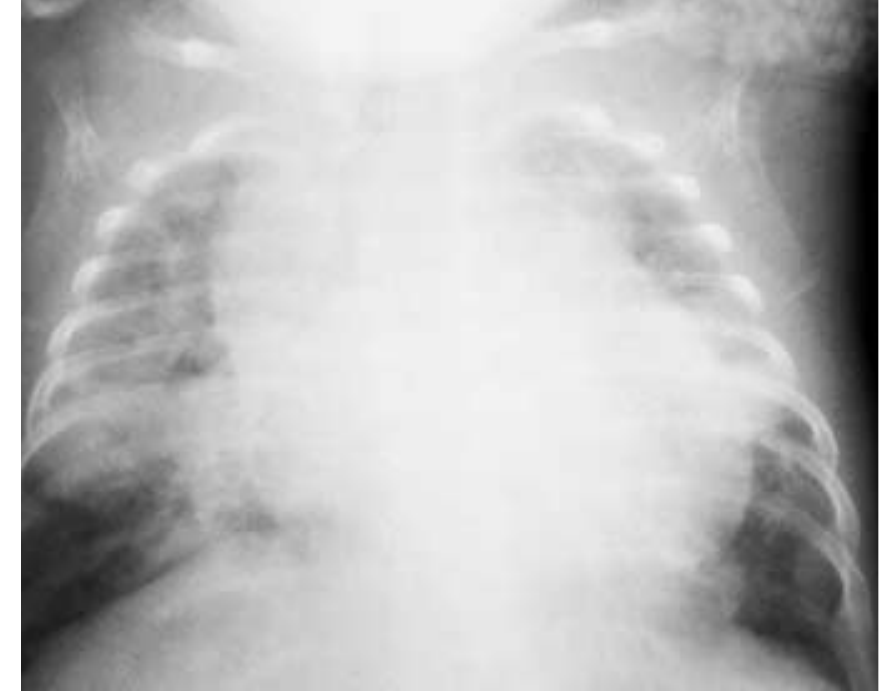
Chest x-ray showing enlarged heart, basal air-trapping and bilat- eral